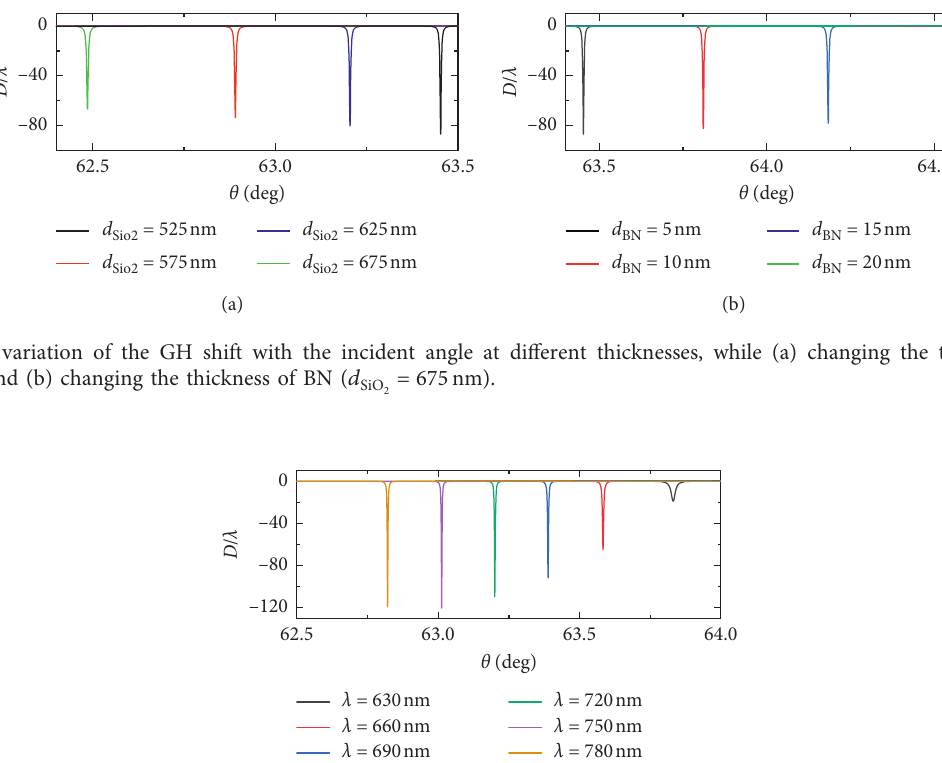
Figure 6: Relationship between the GH shift and incident angle at different